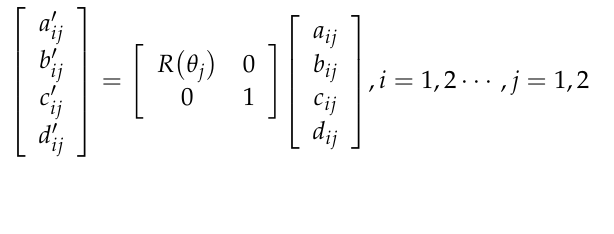
Figure 2. Measurement coordinates.